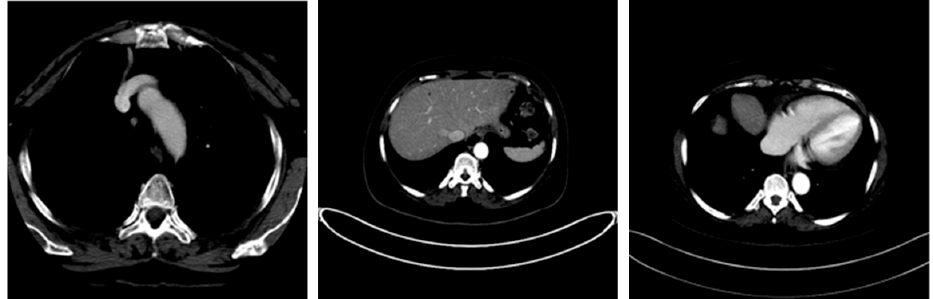
Figure 3. Example of pre-labeled CT images from DeepLesion.